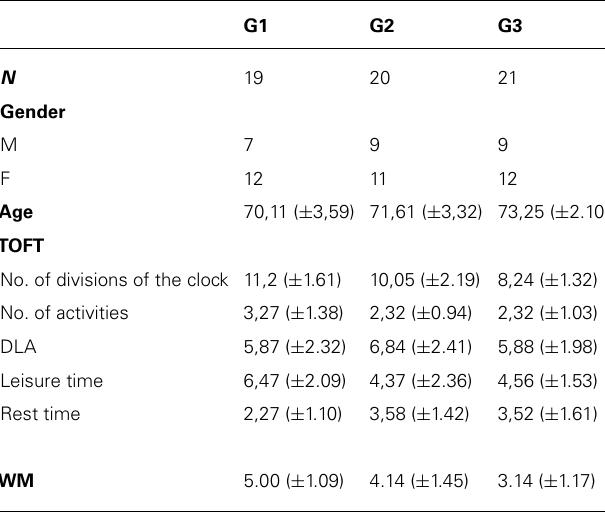
Table 2 | Descriptive data for measuresTOFT,TMT, andWM.